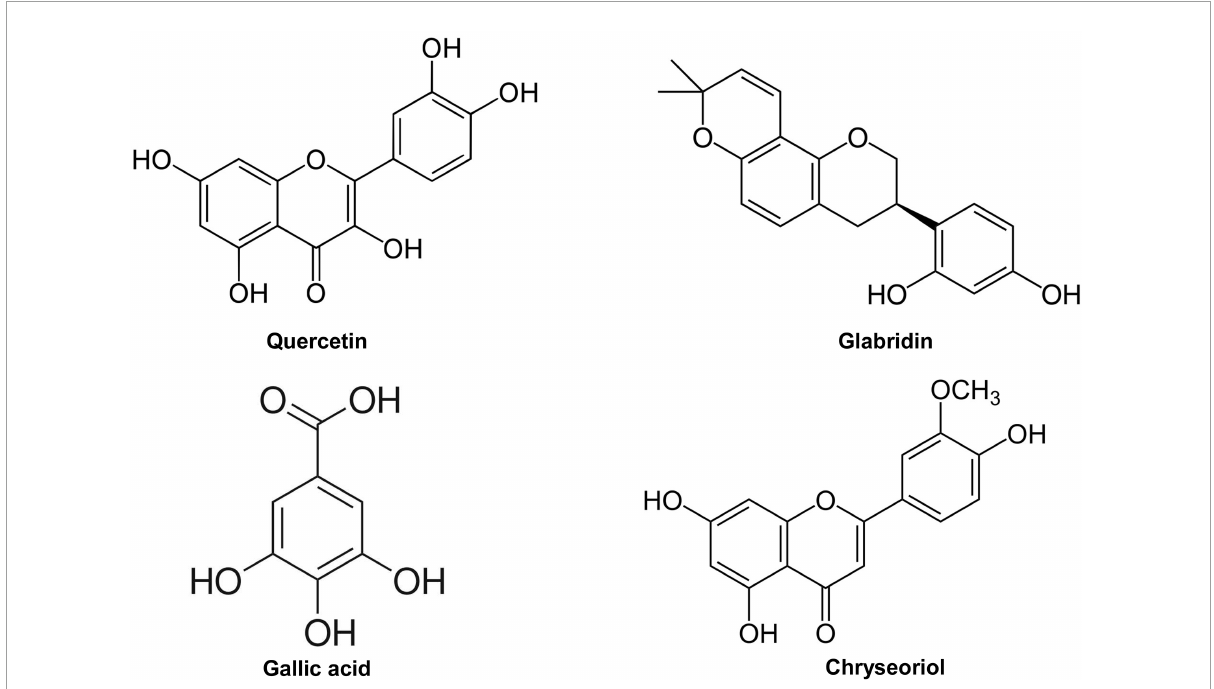
FIGURE1 Chemical structures of quercetin, glabridin, gallic acid, and